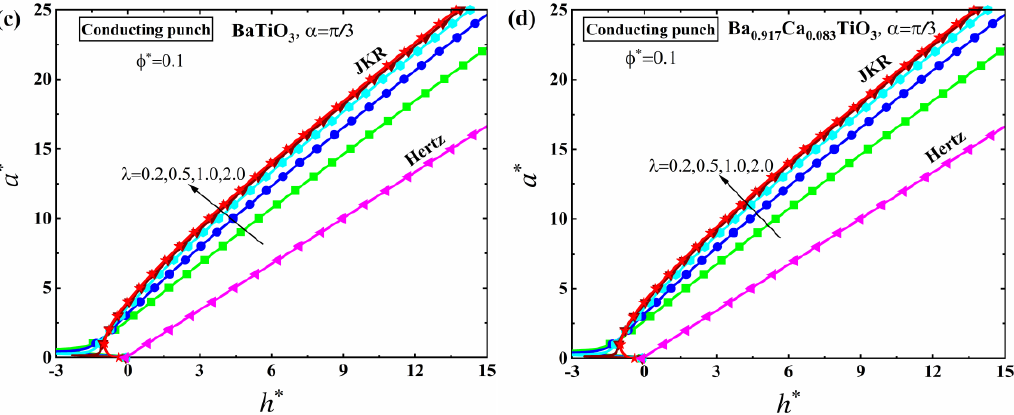
Figure 20. The dimensionless contact radius, a ∗ , as a function of the dimensionless indentation depth, h ∗ , under the action of a conducting punch for the M-D model. ( a ) PZT-4. ( b ) PZT-5A. ( c ) BaTiO 3 . ( d ) Ba 0.917 Ca 0.083 TiO 3 .